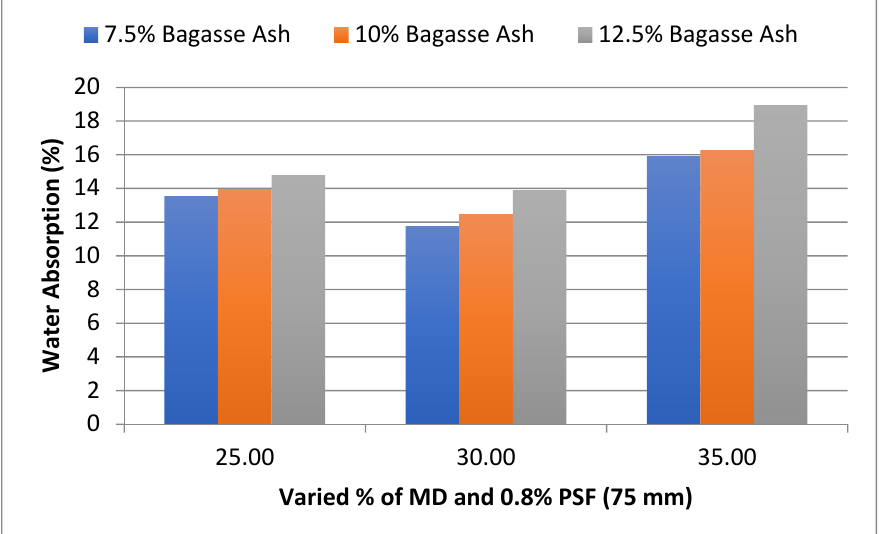
Figure 2. Effect of MD and BA on water absorption of block reinforced with 0.8% PS fiber (75 mm).